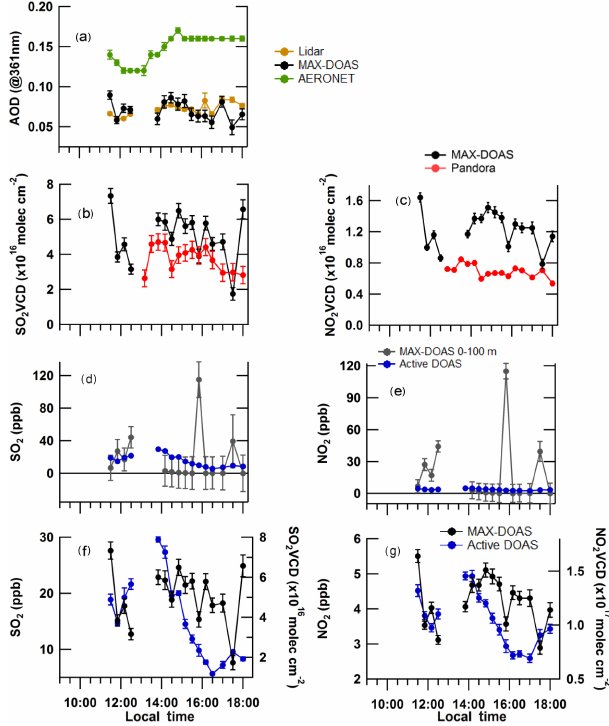
Figure 4. The 23 August AODs from MAX-DOAS, lidar (S ra- tio = 44sr > 14:30LT), and AERONET (30min) (a) ; AODs from MAX-DOAS, lidar (S ratio = 25sr), and AERONET (b) ; MAX- DOAS and Pandora SO 2 VCDs (c) ; MAX-DOAS and Pandora NO 2 VCDs (d) ; MAX-DOAS 0–100m and active DOAS SO 2 mixing ratios (e) ; MAX-DOAS 0–100m and active DOAS NO 2 mixing ratios (f) ; MAX-DOAS VCDs and active DOAS mixing ratios of SO 2 (g) ; and MAX-DOAS VCDs and active DOAS mixing ratios of NO 2 (h) . MAX-DOAS error bars were obtained from the optimal estimation retrieval. Error bars on the lidar and AERONET AODs are the standard error of the temporally averaged values. Error bars on the Pandora VCDs and active DOAS mixing ratios are root-sum- square errors of the standard error from temporal averaging and in- strumental precision and the DOASIS retrieval error, respectively. See Sect. 2.3.3 for details.